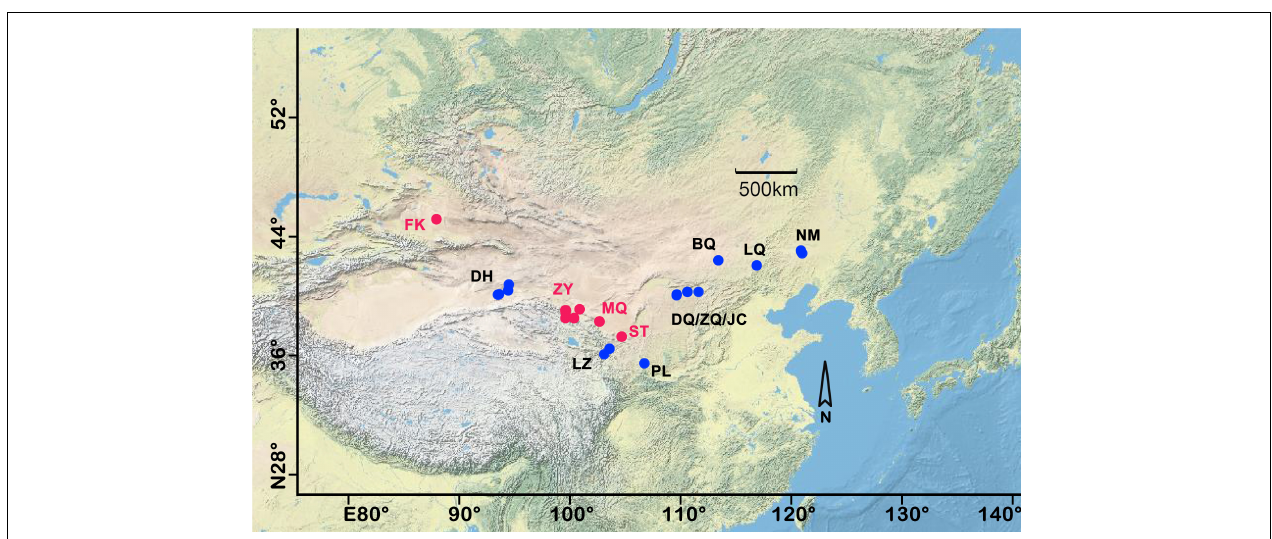
FIGURE 1 | Study area and sampling plots of north China. Each sample plot was named by the abbreviation of the place name. The red dots indicated that three different successional stages of biocrust were synchronously collected. FK, Fukang; DH, Dunhuang; ZY, Zhangye; MQ, Minqin; LZ, Lanzhou, ST, Shapotou, PL, Pingliang, DQ, Datela Qi; ZQ, Zhungeer Qi; JC, Jiechai; BQ, Bai Qi; LQ, Lan Qi; NM, Naiman. For more detailed sample information, refer to our previous research (Li and Hu,